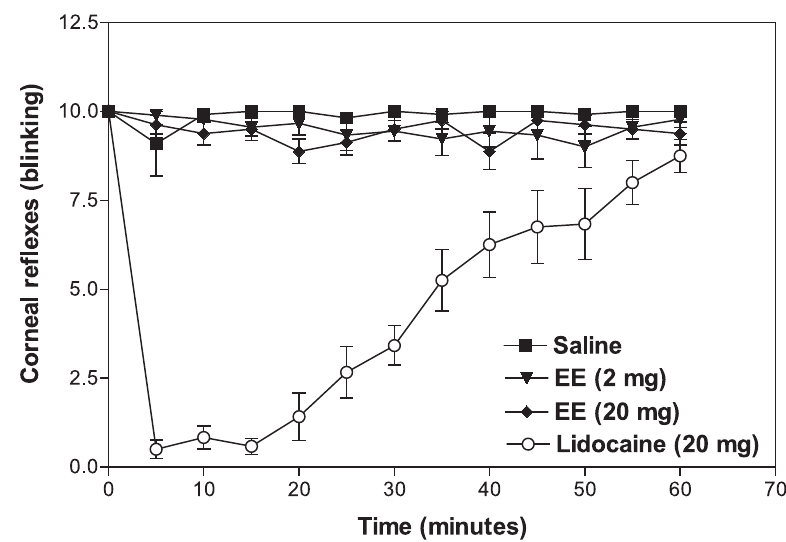
Figure 2 - Surface anesthesia on the cornea of rabbits. Instillation of lidocaine (2 %) completely abolishes the corneal reflex (p < 0.05) in rabbits (n= 8-11 animals/group) 5 minutes after application, and this effect is reversed in 1 hour. The ethanolic extract of Ottonia martiana, 2 or 20 mg, and saline did not inhibit blinking.